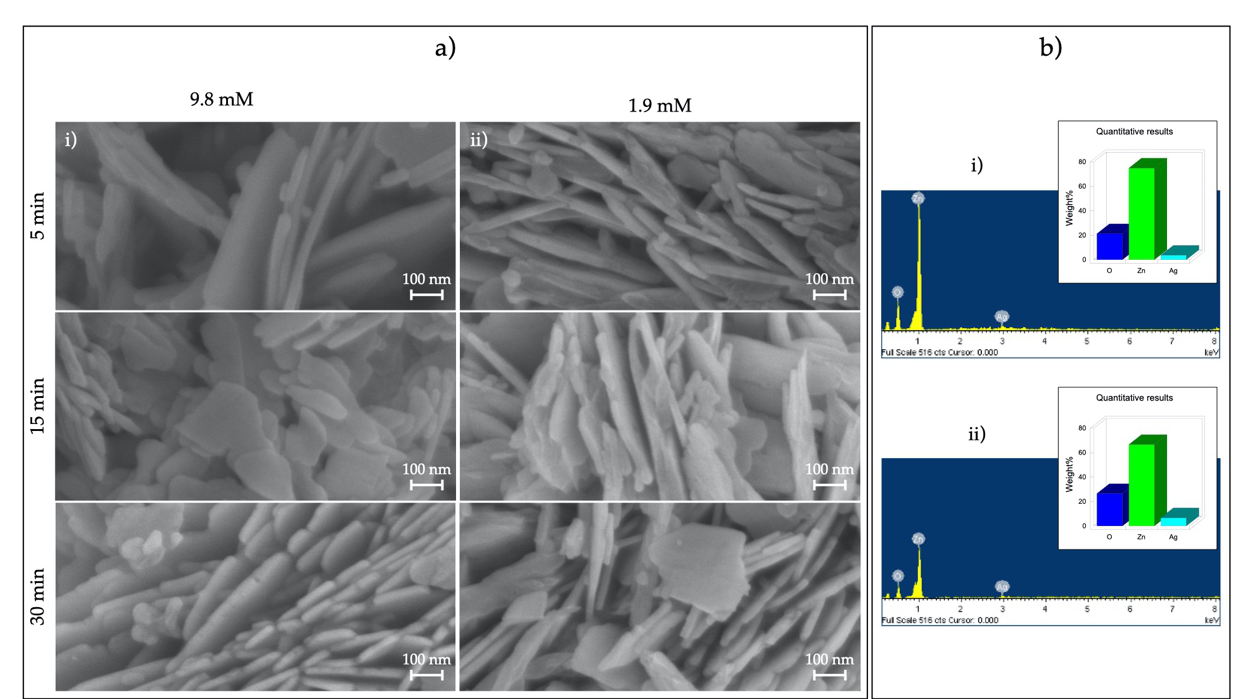
Figure 3. ( a ) SEM images of Ag/ZnO MSs obtained with ( i ) 9.8 and ( ii ) 1.9 mM AgNO 3 and 5, 15, and 30 min of radiation time and ( b ) EDS of Ag/ZnO MSs obtained at 5 min with ( i ) 9.8- and ( ii ) 1.9-mM silver nitrate.